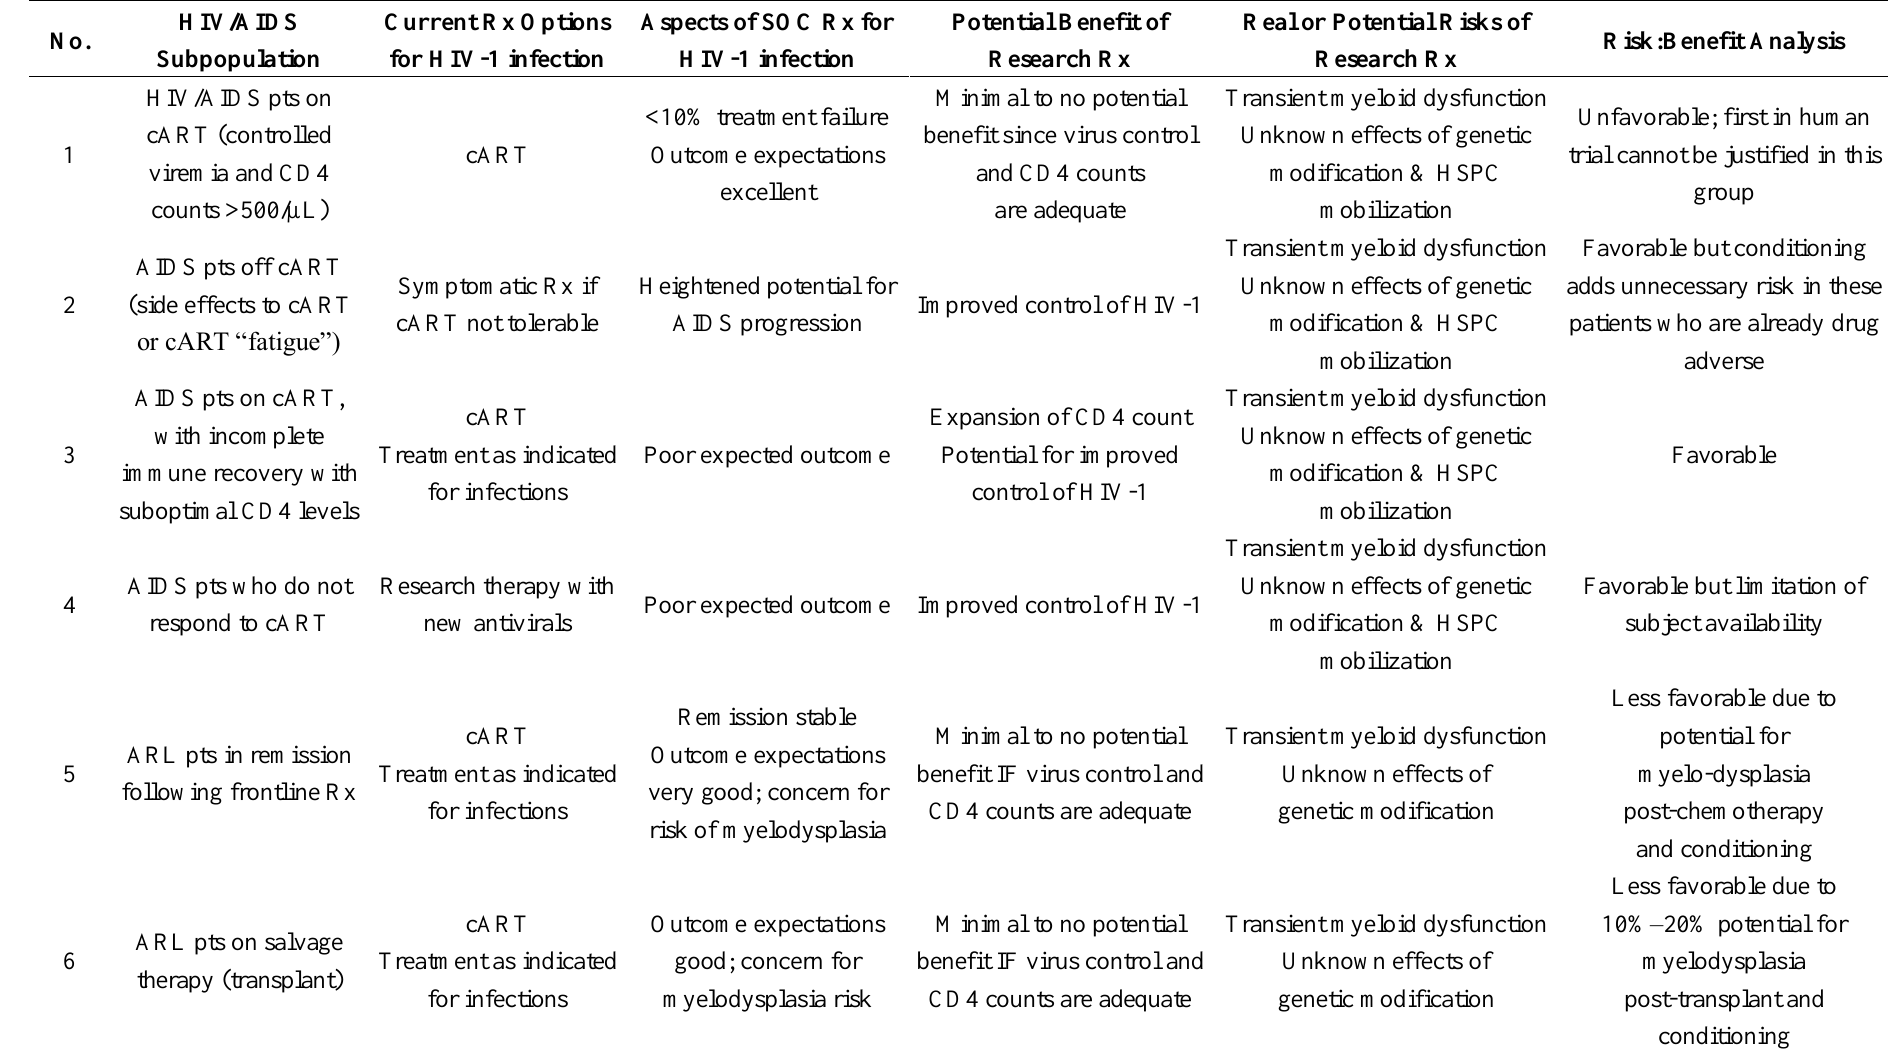
Table 2. Framework for risk-benefit analysis for HIV-1-infected patient populations that could be targeted with HSPC-based gene therapy.